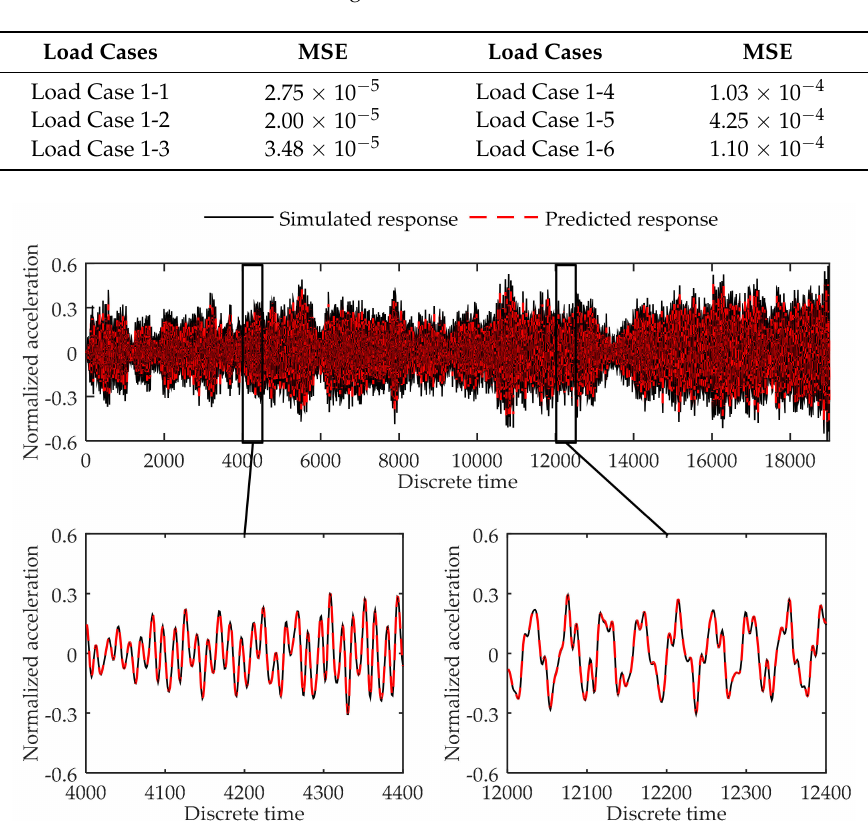
Figure 5. Comparison between the predicted response and true responses of the 4th degree of freedom at the 6-DOF system in Load Case